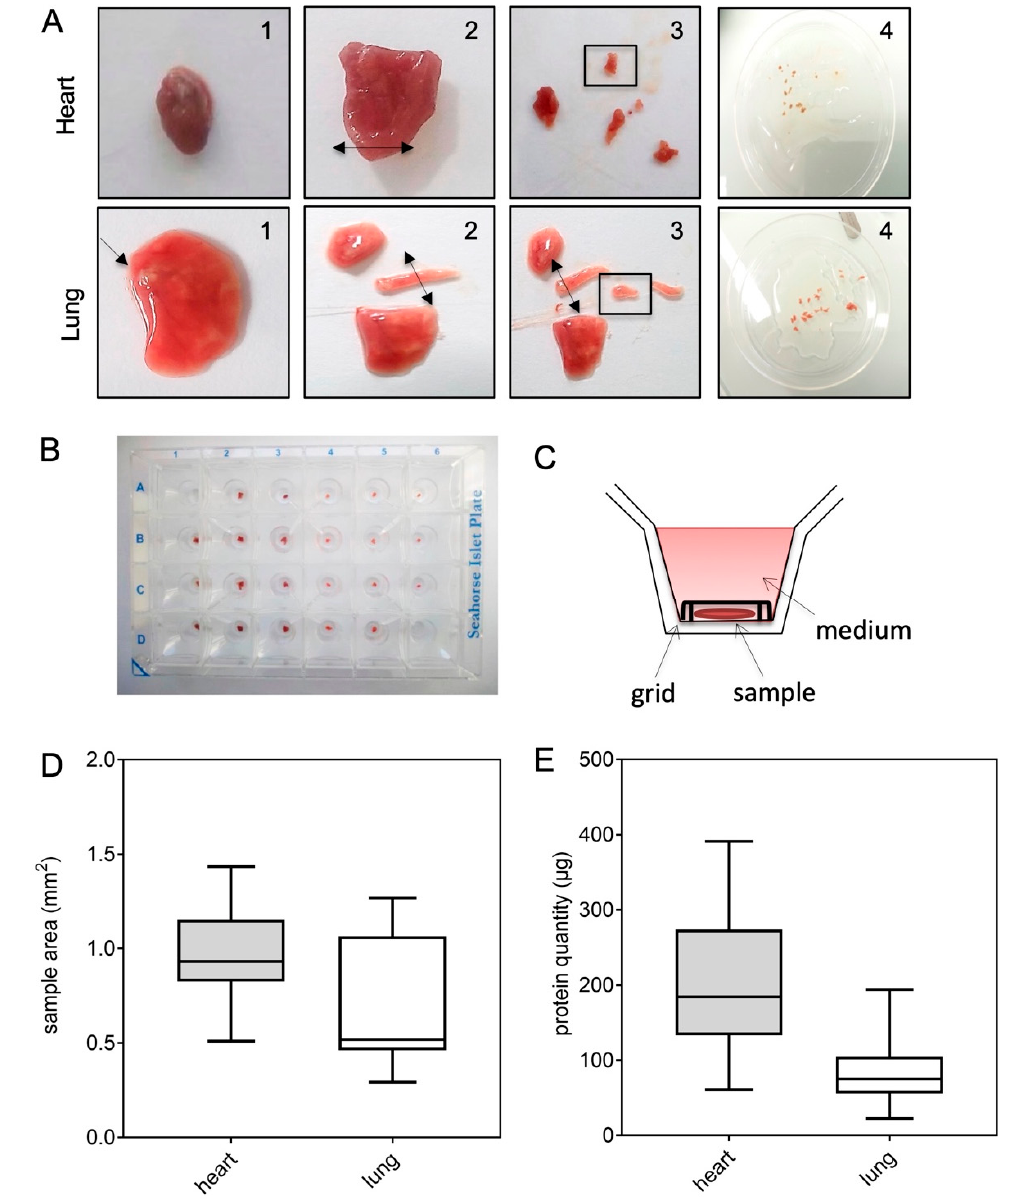
Figure 1. Sample preparation for reproducible respirometry experiments. Samples were obtained from heart and lung tissues and processed as shown in ( A ). Transversal cuts were performed with a scalpel, starting from the left ventricular apex for the heart, and the main bronchi for the lung, as indicated by the arrows (1 and 2). Size-matched samples (framed) were prepared as thin as possible (3 and 4). One sample per well was then placed in a Seahorse Islet plate ( B ). Each sample was maintained at the bottom of the plate using the grid provided with the Seahorse Islet plate before filling the well with medium ( C ). Samples mean area (mm 2 ) ( D ), and protein quantity ( µ g) ( E ) were obtained for the optimal quantification of the oxygen consumption rates (OCR) in heart (grey) and lung (white) tissues ( n = 10).